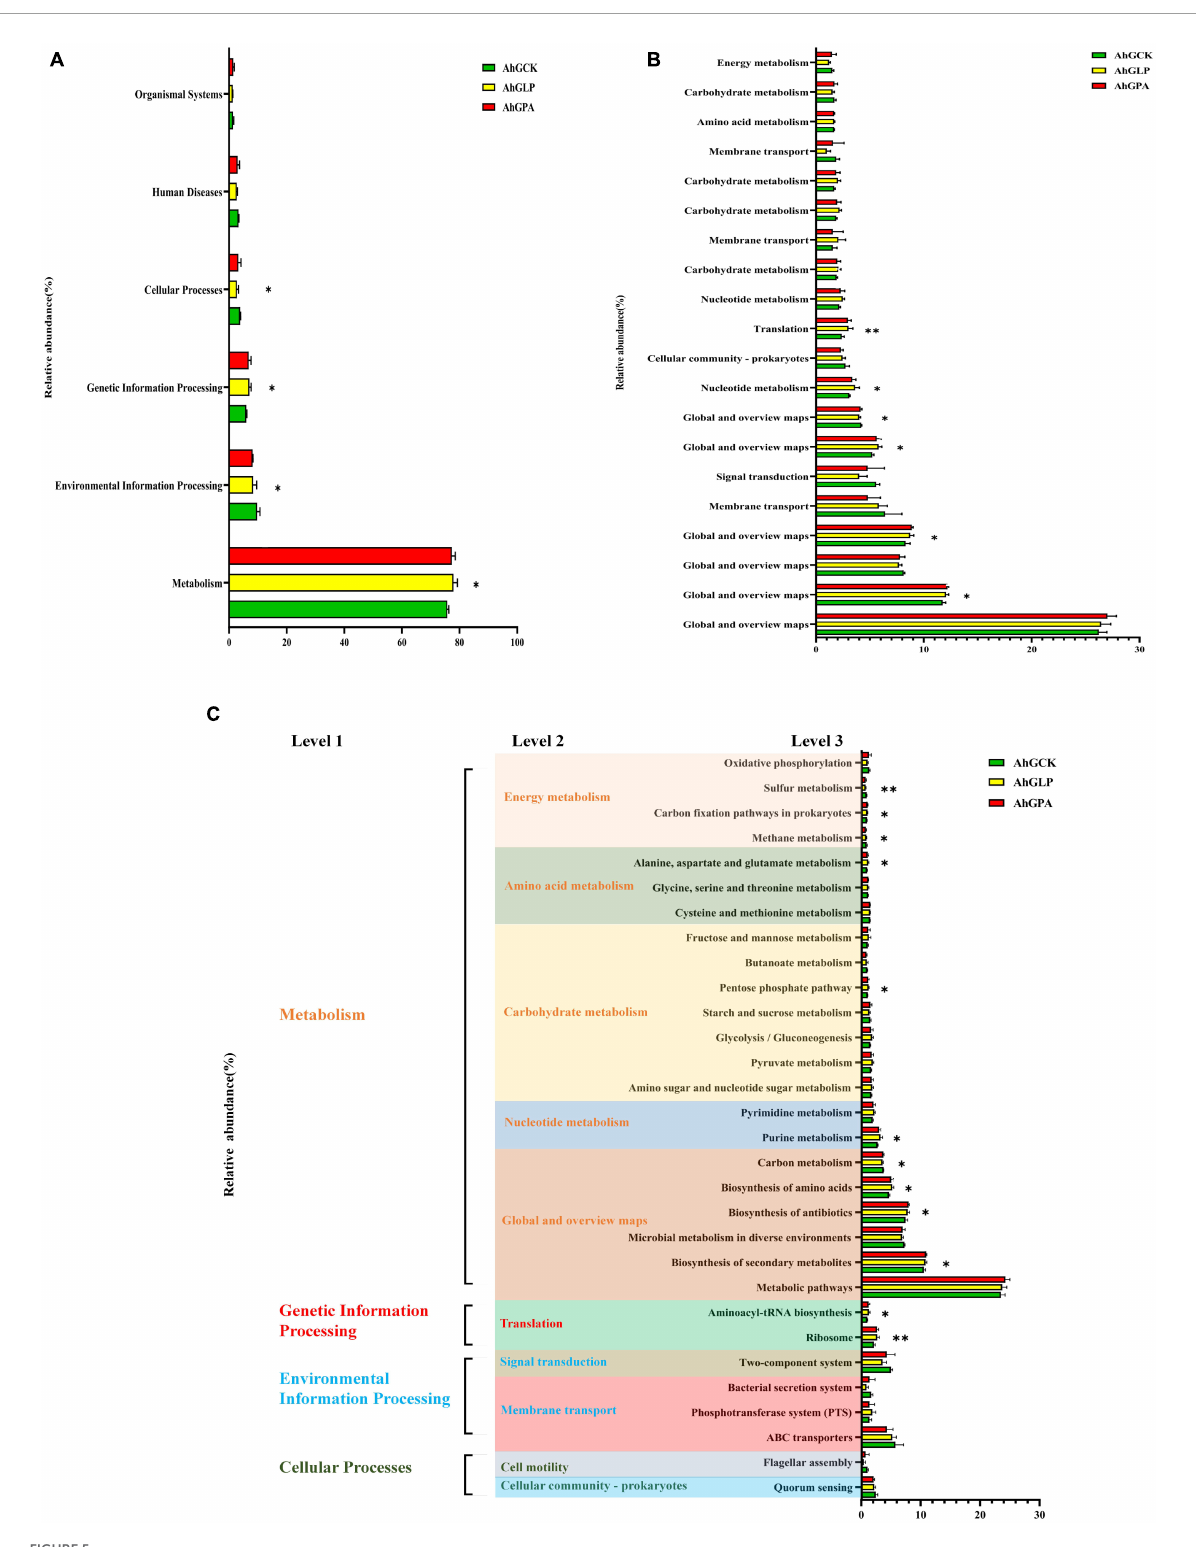
FIGURE5 Functional predictions for silage microbiota with significantly different Kyoto encyclopedia of genes and genomes (KEGG) pathways ( p < 0.05) among the three groups of silage (AhGCK, AhGLP, and AhGPA). KEGG pathways at level 1 (A) , level 2 (B) , and level 3 (C) are represented. AhGCK, control; AhGLP, L. plantarum ; AhGPA, propionic acid. ∗ p < 0.05; ∗∗ p <